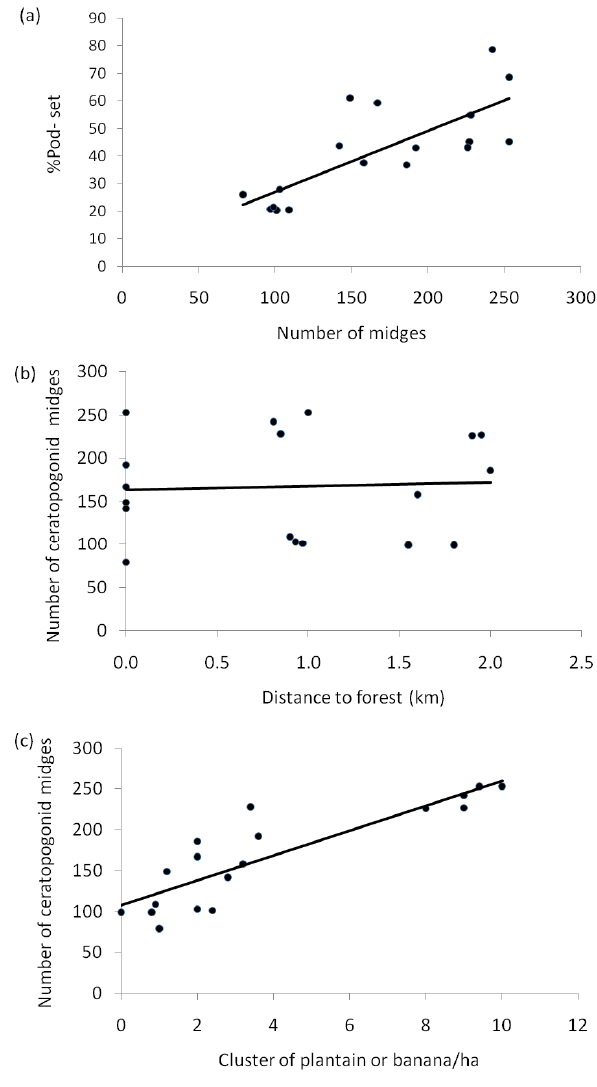
F IG . 1. Relationship between number of cocoa pollinating ceratopogond midges: (a) Pod-set of cocoa; y = 4.839 + 0.221 x, r2